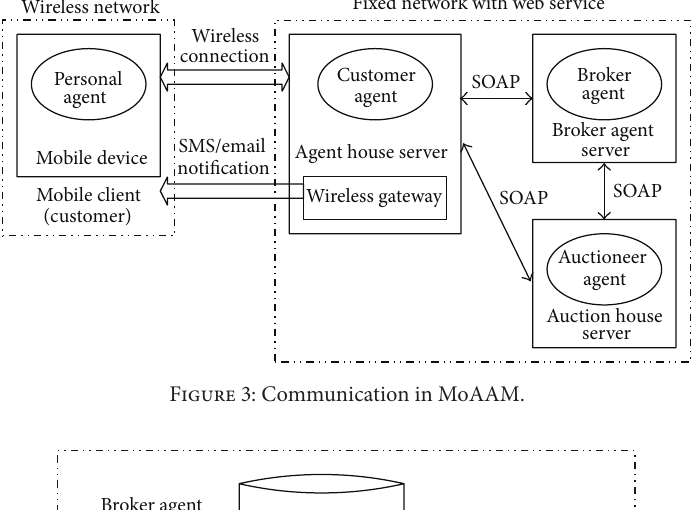
Figure 3: Communication in MoAAM.